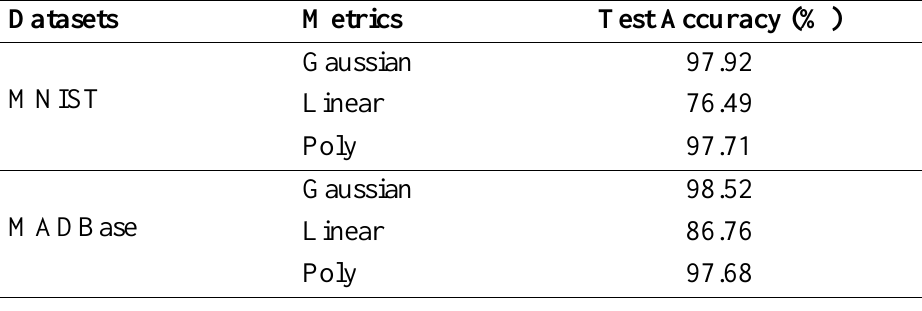
Table 2 . Classification results with the SVM